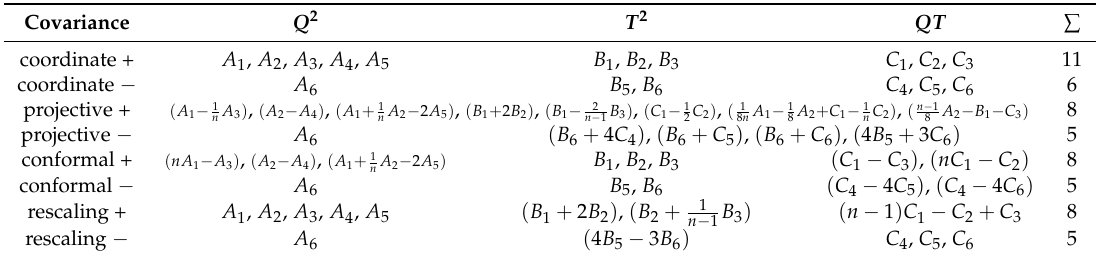
Table 3. The scalars and co-covariants in the three versions of rescalings, separated according to parity. (The linearly independent combinations are not unique of course.) In the odd-parity cases, n =